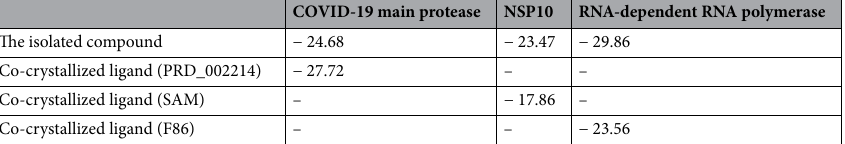
COVID-19 main protease NSP10